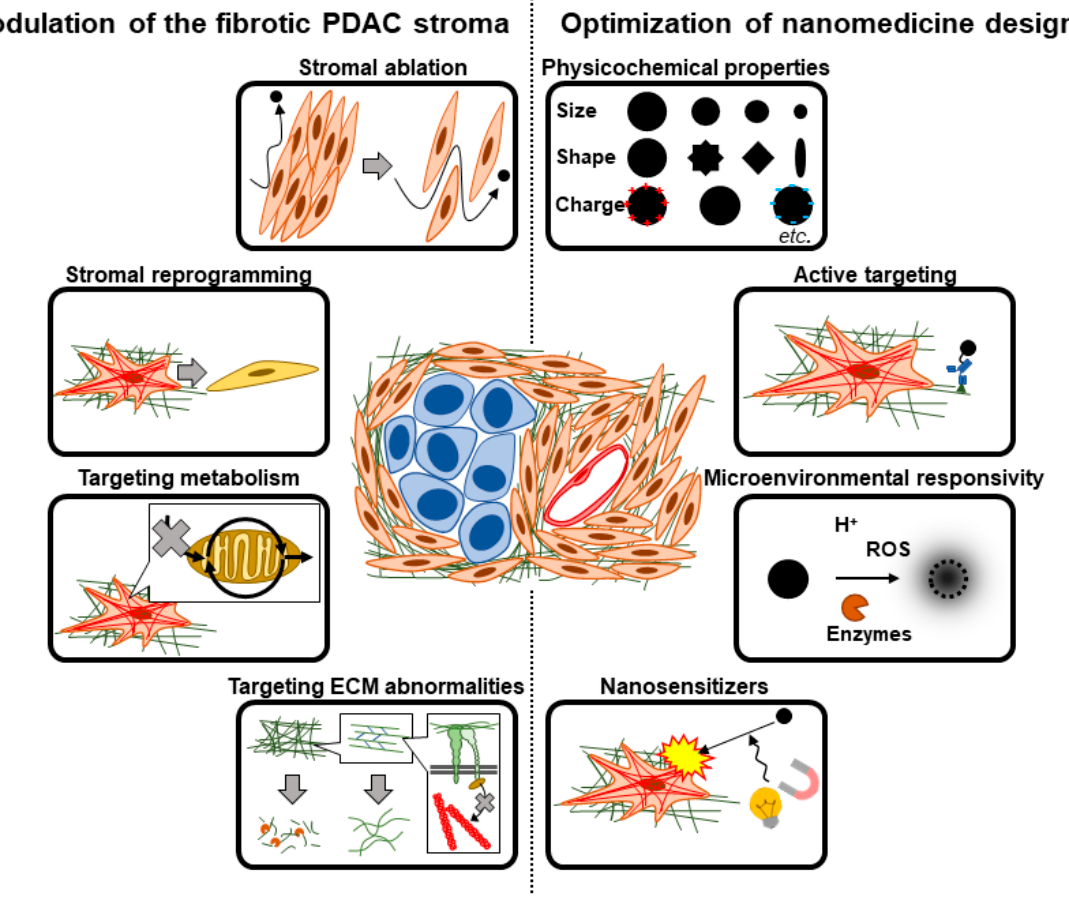
Figure 4. Therapeutic strategies to overcome fibrotic barriers to nanomedicine. To overcome the fibrotic barriers to nanomedicine in the PDAC tumor microenvironment (TME), the fibrotic stroma could be modulated ( left ) and/or the nanomedicine design could be optimized ( right ). Strategies to modulate the fibrotic PDAC stroma include stromal ablation, stromal reprogramming, targeting aberrant CAF metabolism, and targeting ECM abnormalities. Strategies to optimize nanomedicine design include tuning of physicochemical properties, installation of moieties for active targeting and/or microenvironmental responsivity, as well as the use of nanomedicine as nanosensitizers for locoregional stromal